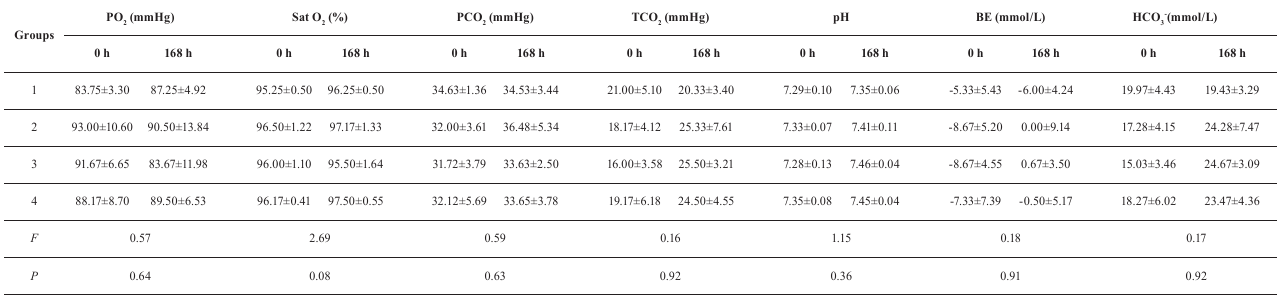
TABLE V - B lood gas parameters changes of groups (